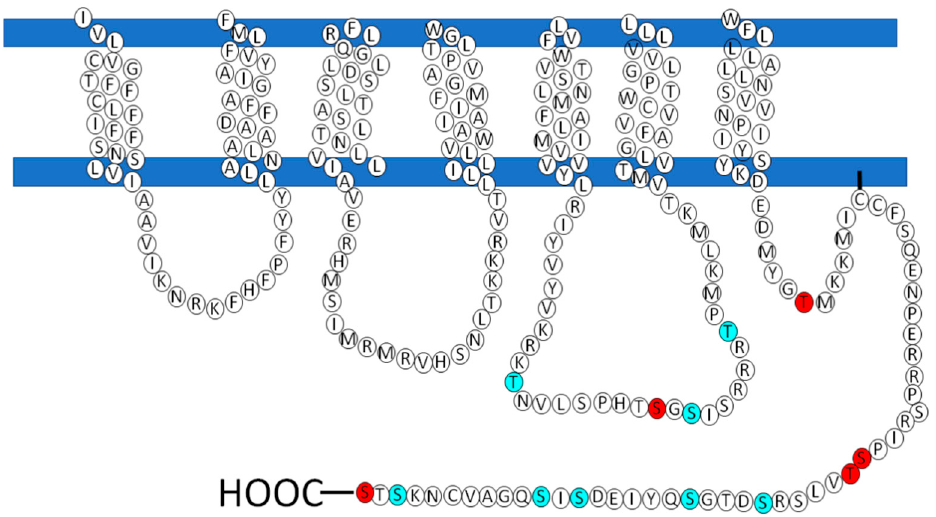
Figure 6. In silico prediction of serine and threonine sites phosphorylated by GRK, PKA and PKC. LPA 3 structure is represented, showing (in red) the putative sites targeted by GRK and (in cerulean) putative sites phosphorylated by PKA or PKC.